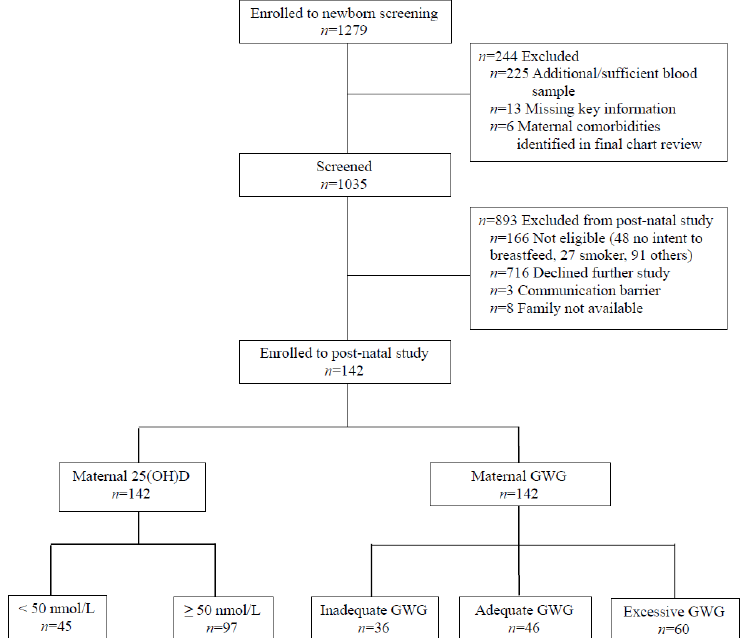
Figure 1. Participant flow diagram. Participant flow diagram illustrating the number of mother–infant dyads assessed for eligibility 24–36 h after delivery, enrolled in newborn screening, screened, and enrolled in postnatal study with distribution according to maternal vitamin D status (insufficient vs. sufficient) and GWG categories (inadequate, adequate, and excessive). Abbreviations: 25(OH)D: 25-hydroxyvitamin D, and GWG: gestational weight Table 1. Maternal and infant characteristics according to maternal 25(OH)D and gestational weight gain categories.